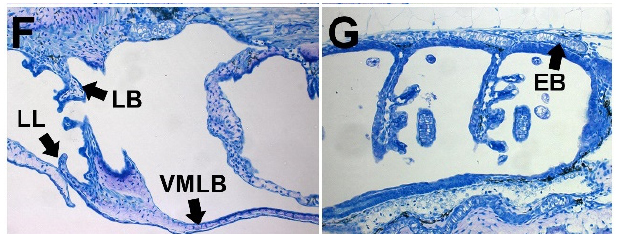
Figure 6. Histological differences in larval lamprey cartilages. ( A ) Left lateral view of stage T30 lamprey. Scale bar approximately 100 μ m. ( B , D , F ) Toluidine blue staining of T30 sagittal sections of the anterior head skeleton. ( C , E , G ) Toluidine blue staining of T30 sagittal sections of the posterior pharyngeal skeleton. Lamprey cartilages can be divided between mucocartilage (pale purple matrix) and hyaline-like tissues (discoidal morphology, thin blue matrix), but there are further differences in morphology and histology within these groups. Keywords: BA: branchial arches; EB: epibranchial